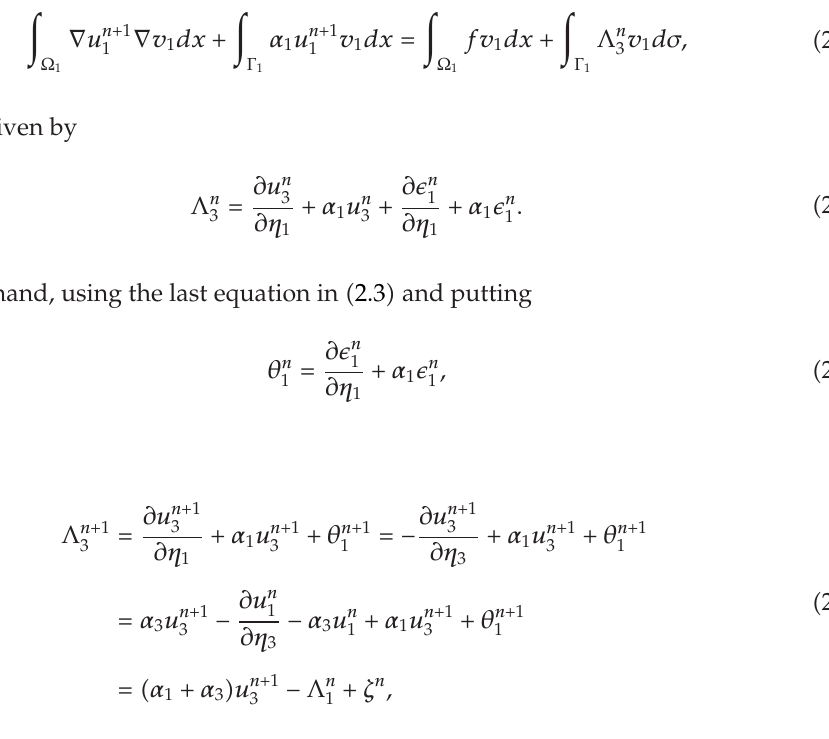
Algorithm 2.1. The sequences (cid:2) u n (cid:11) 1